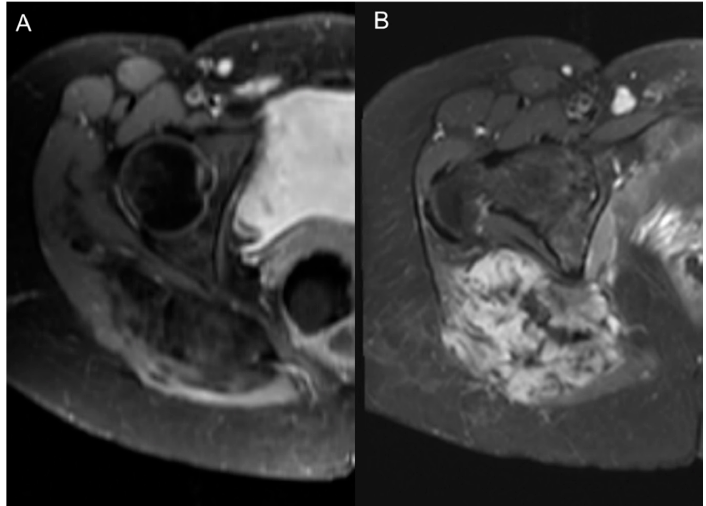
Figure 4. Axial T1 fat suppression contrast ‐ enhanced MRI images of the pelvis in a female patient with fibro ‐ desmoid tumor of the gluteal region. ( A ) Post ‐ and ( B ) pre ‐ treatment images after initiation of anti ‐ angiogenic therapy.